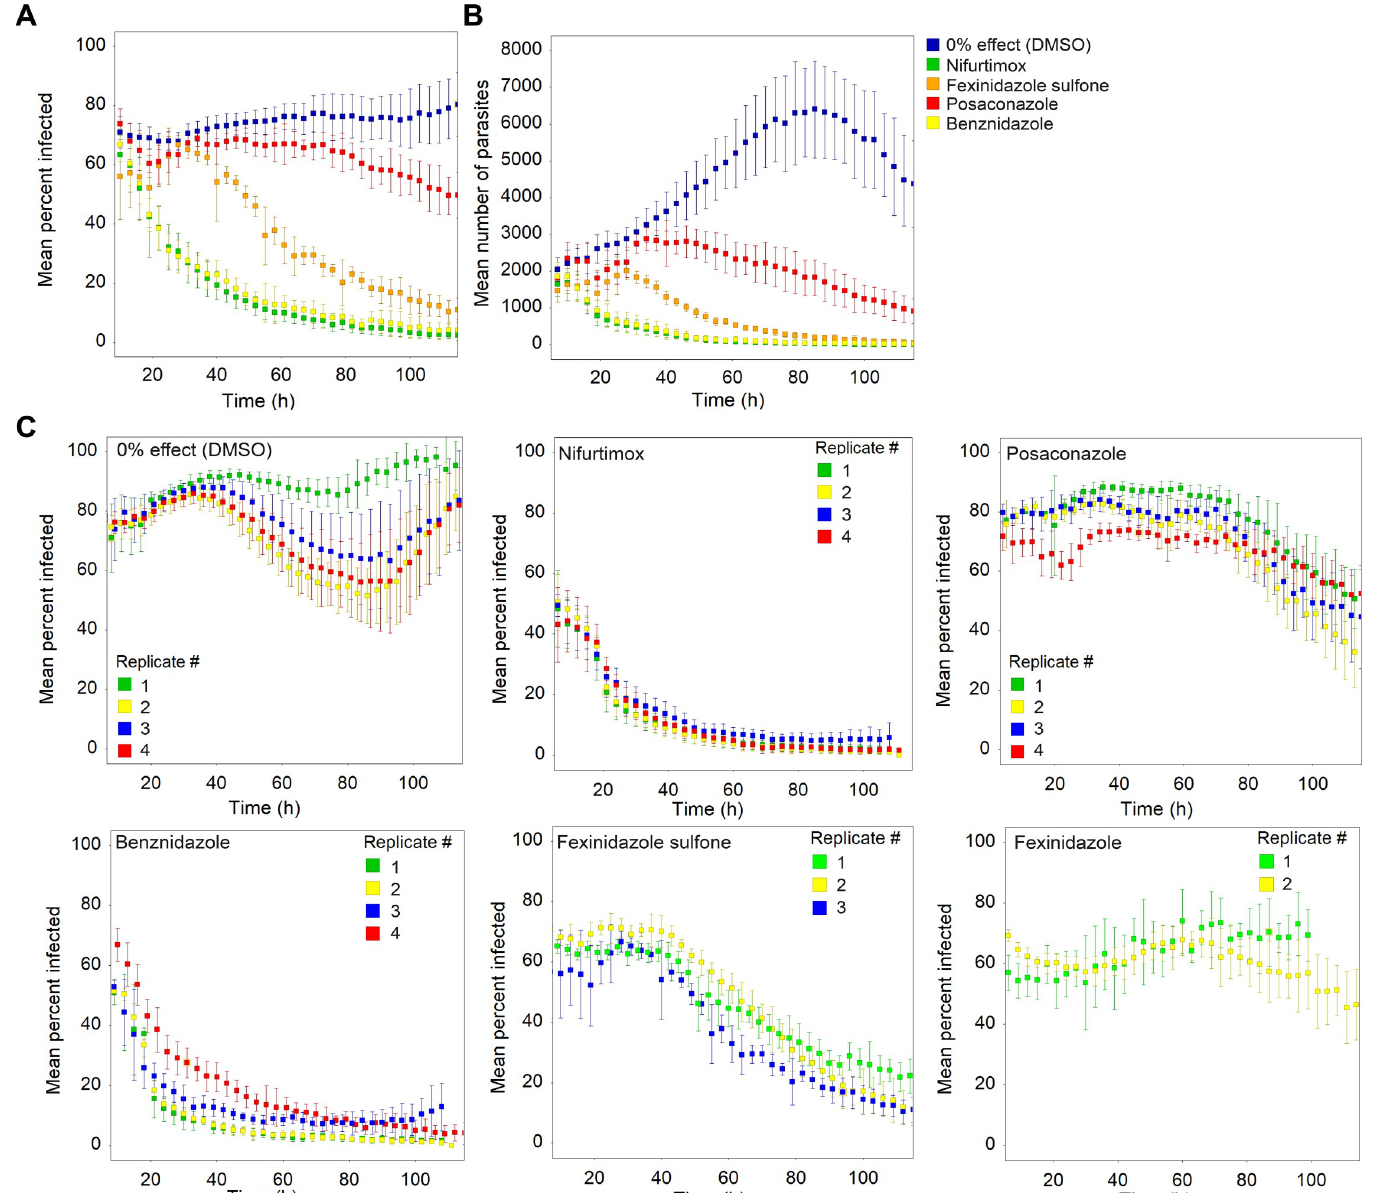
Fig 2. Live rate-of-kill curves for reference compounds. A) percent infected host cells versus time, B) mean total number of intracellular amastigotes per well versus time for the same images analysed in A, C) biological replicates of reference compounds plotted as percent infected cells versus time. Concentrations used are as